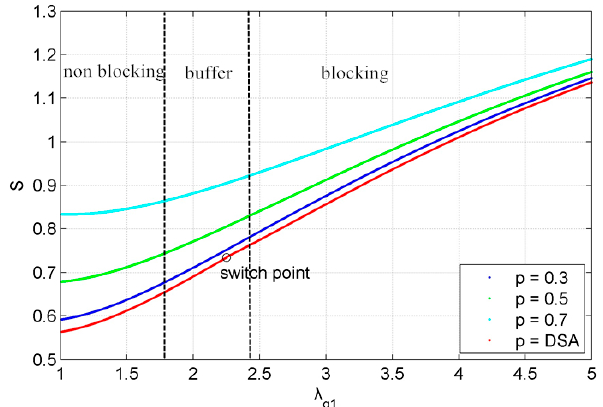
Figure 9. The blocking coefficient of the dynamic spectrum allocation (DSA) algorithm and fixed priority factors.